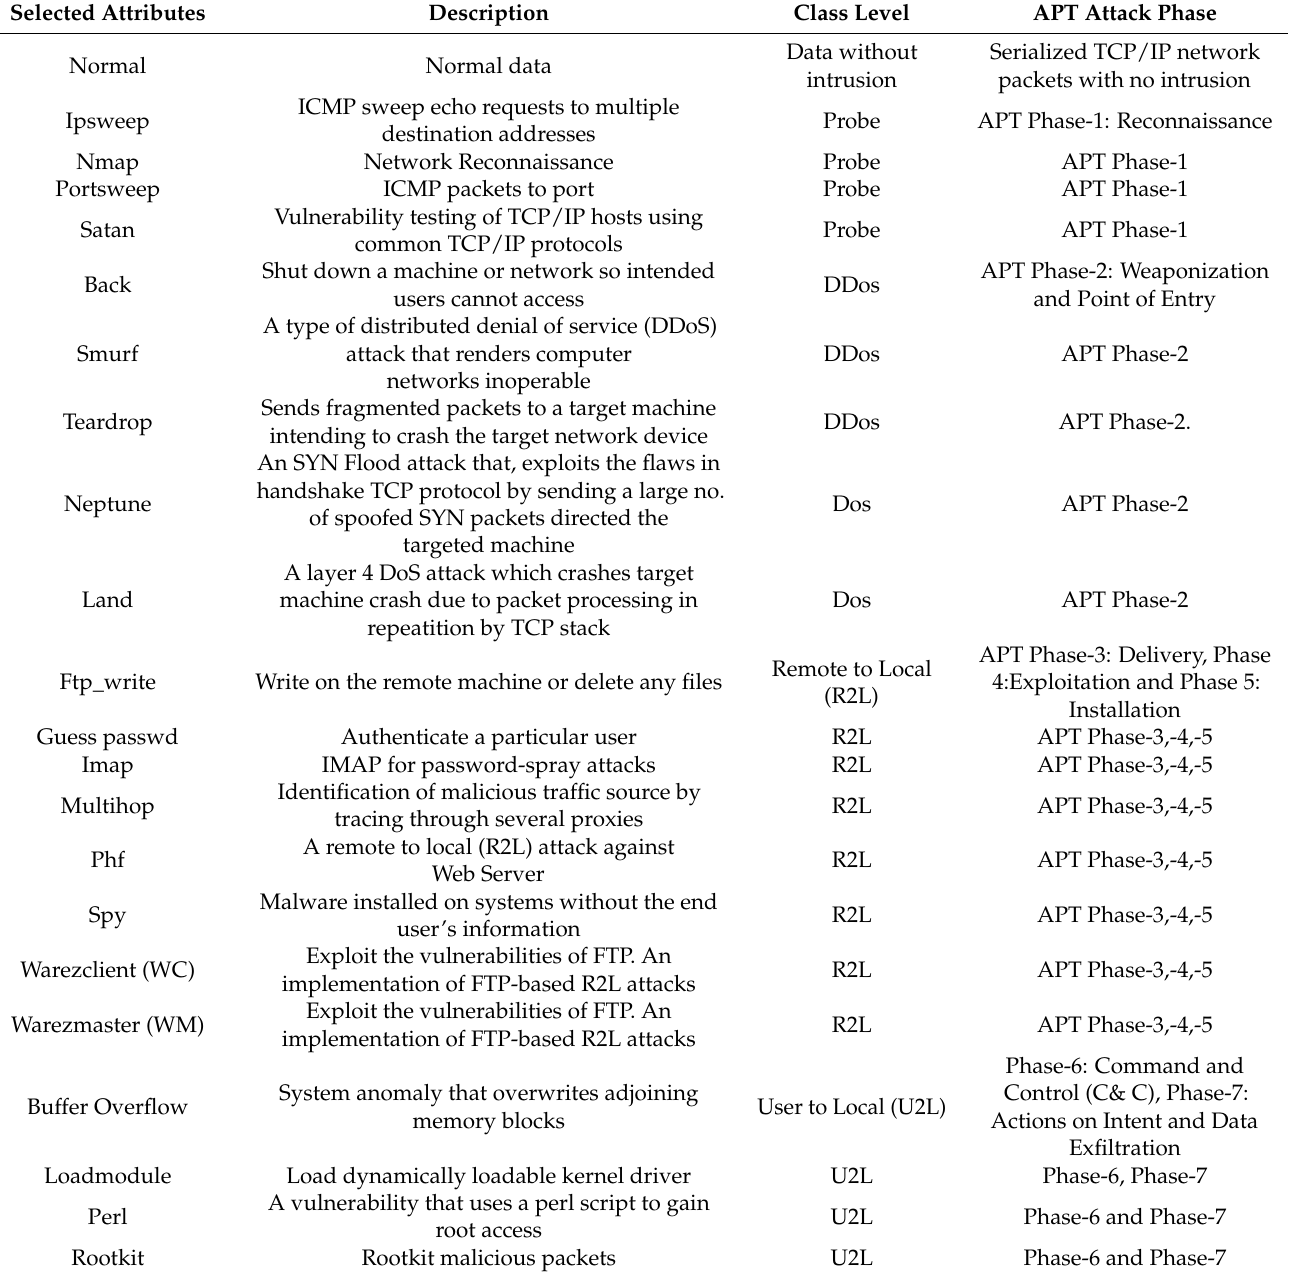
Table 3. Feature Selection and